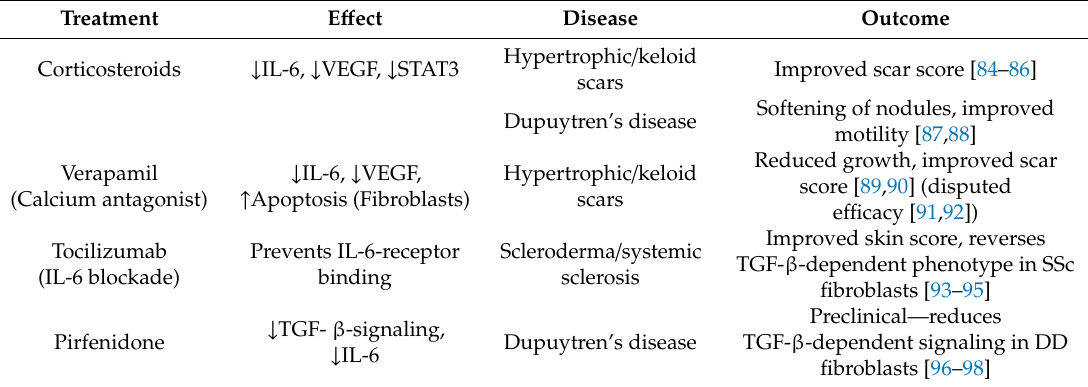
Table 1. Treatments that modulate IL-6 in cutaneous